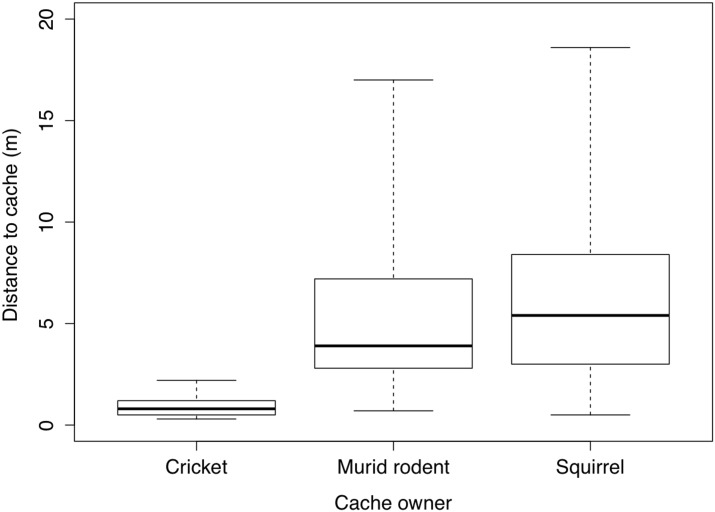
Distance to primary cache locations.A boxplot representing distances (in metres) between experimental plots and primary caches made by different cache owners: cricket (Brachytrupes sp., n = 71 caches), murid rodent (n = 176 caches), and squirrel (hoary-bellied squirrel, n = 62 caches).